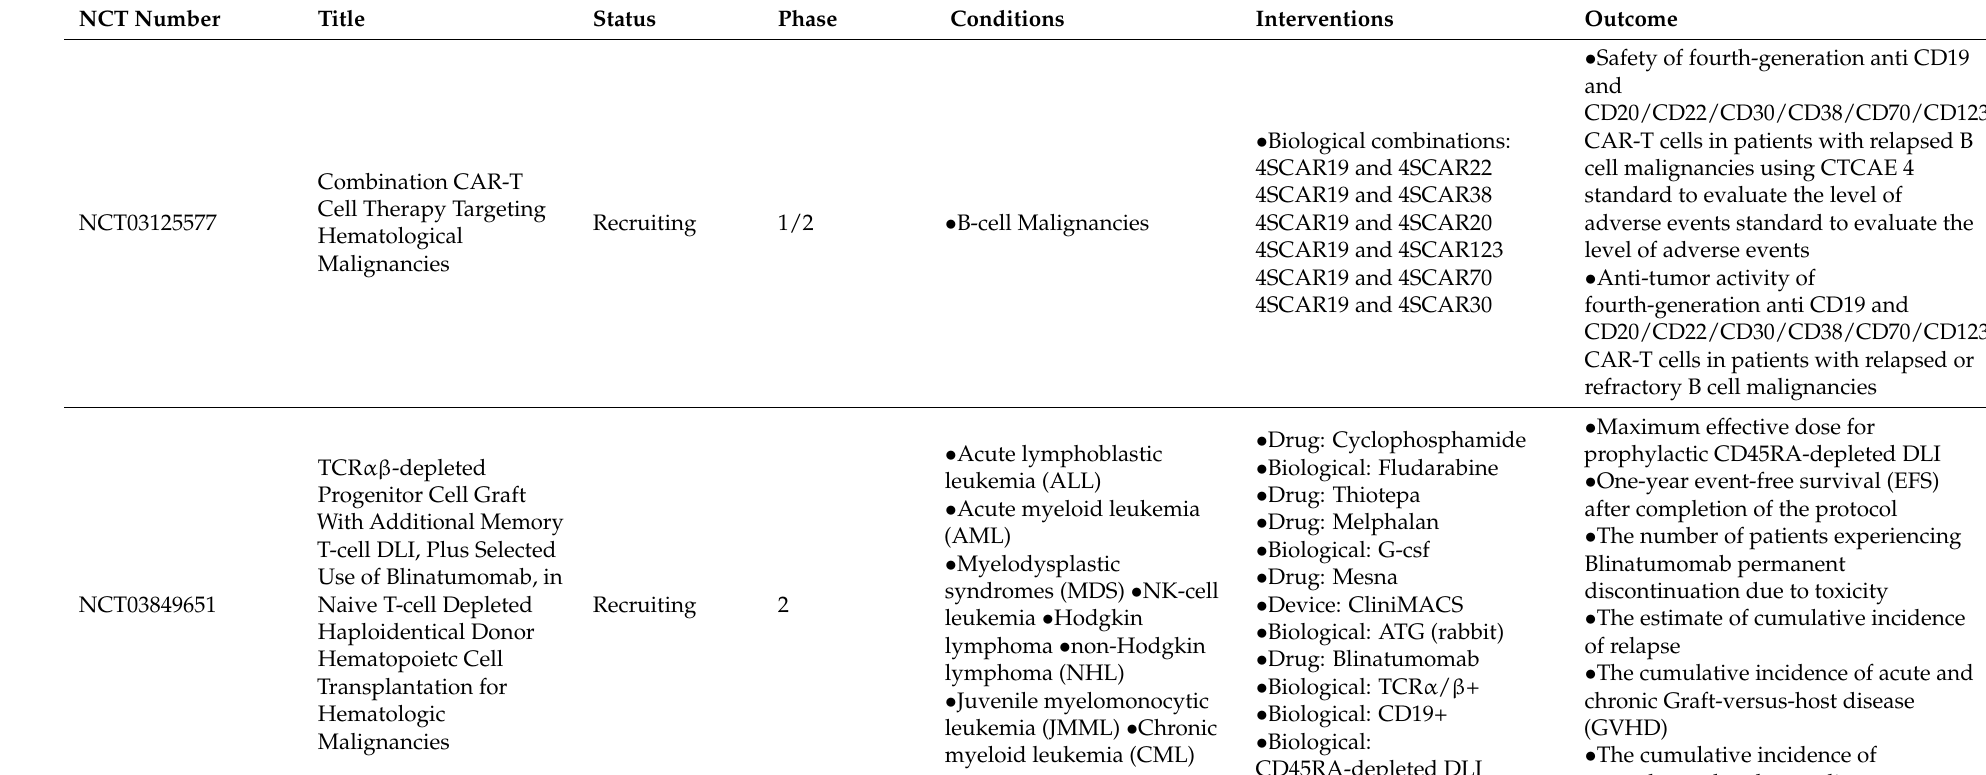
Table A1. Select clinical trials investigating the safety of genetic therapy—19 September 2021